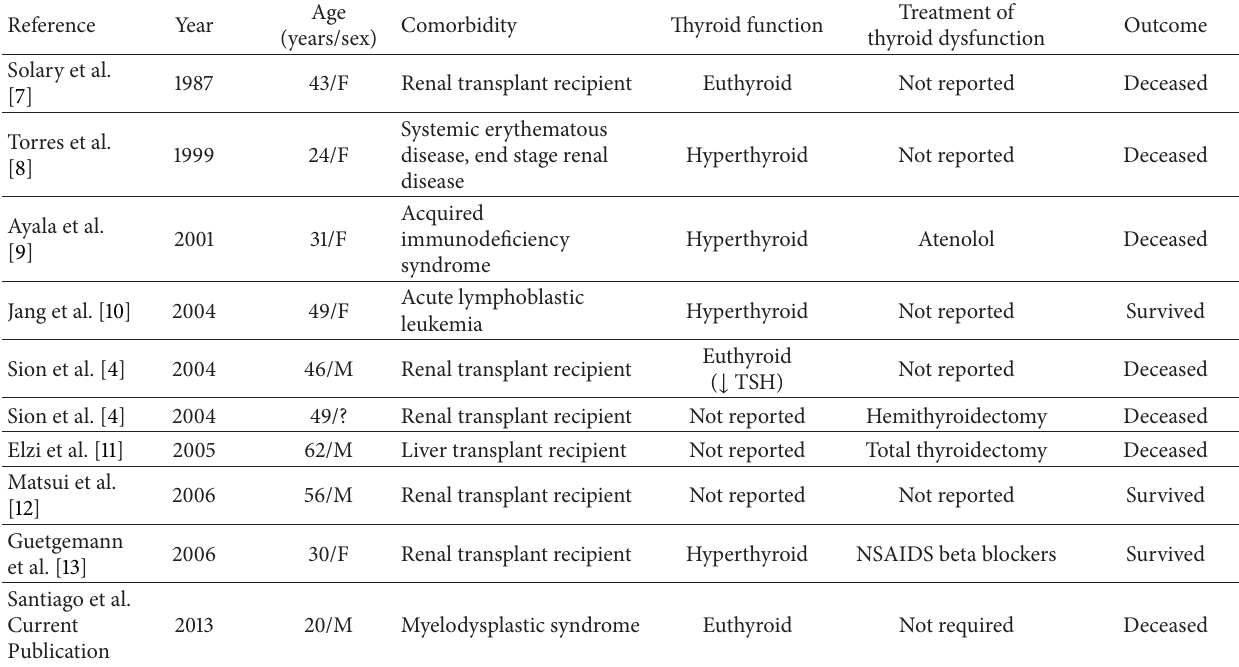
Table 2: Review of the medical literature describing cases of the Aspergillus thyroiditis diagnosed antermortem by fine needle aspiration (FNA) cytology in patient over 18 years